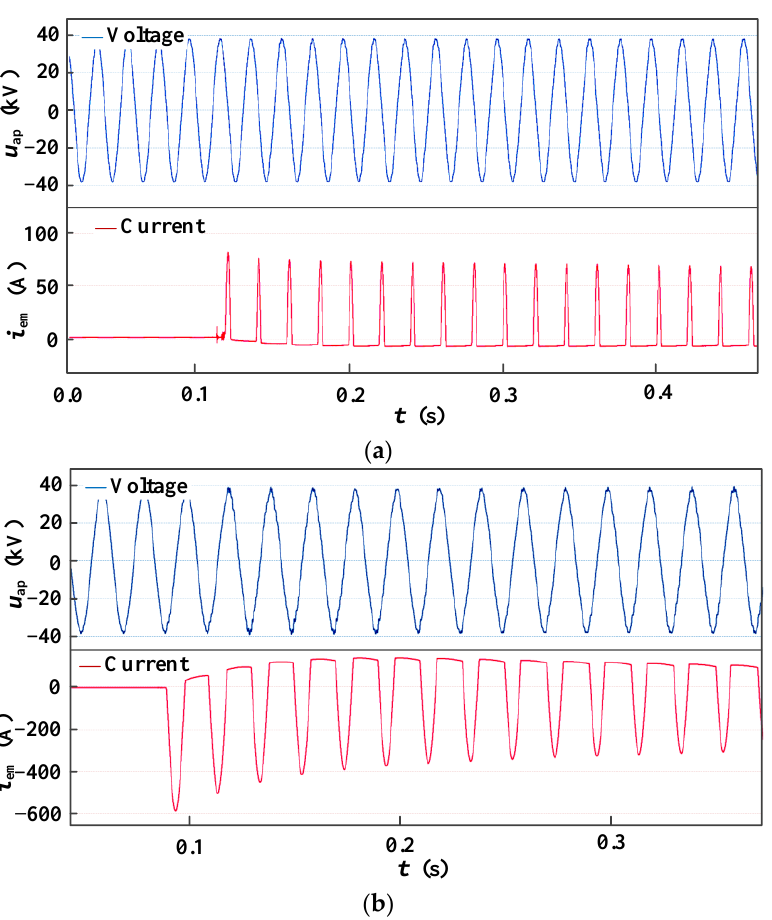
Figure 24. Partially enlarged waveforms of the magnetizing inrush current. ( a ) Enlarged view of the closed inrush current (in the forward direction). ( b ) Enlarged view of the closed inrush current (in the reverse direction).